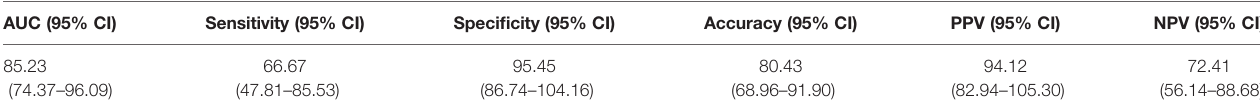
TABLE 6 | Diagnostic performance of the new disease activity assessment tool in the validation